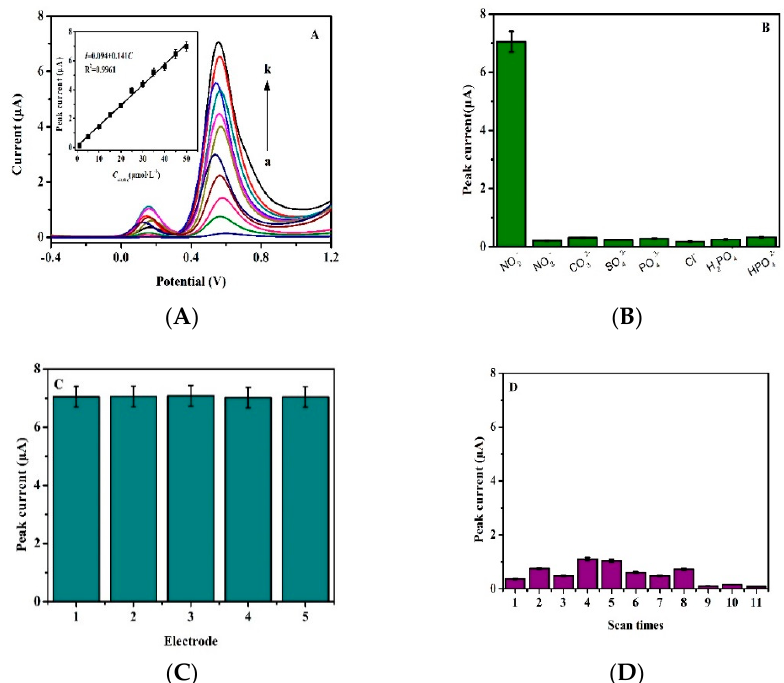
Figure 6. ( A ): DPV for different concentrations of nitrite on Fc-ECG/SPE (a-k: 1.0, 5.0, 10, 15, 20, 25, 30, 35, 40, 45, 50 μ mol·L − 1 ), insert: calibration plot for various concentrations of nitrite; ( B ): The selectivity of Fc-ECG/SPE sensor for nitrite, NO 3- , CO 32- , SO 42- , PO 43- , Cl - , H 2 PO 4- , and HPO 42- , the concentration of each compound is 100 μ mol·L − 1 ; ( C ): The repeatability of Fc-ECG/SPE sensor; ( D ): The stability of Fc-ECG/SPE sensor.